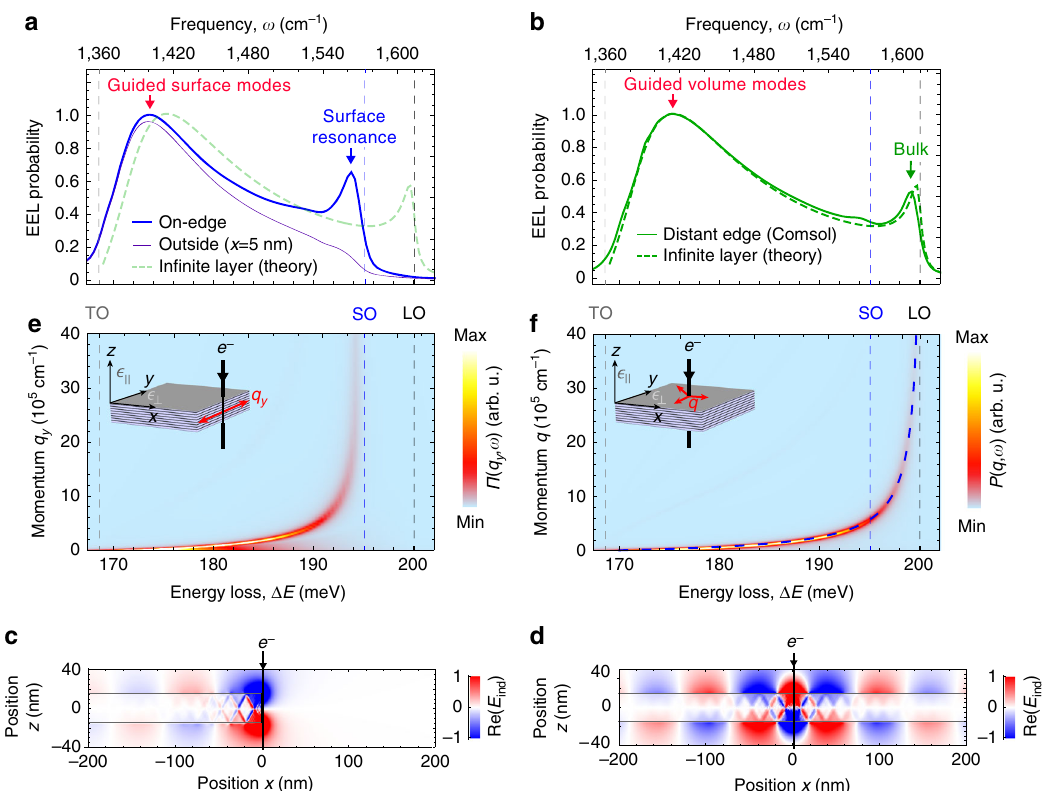
Fig. 5 Volume vs. edge-localized hyperbolic polaritons. a EEL probability spectrum of 30-nm-thick semi-in fi nite slab for an on-edge electron trajectory ( blue ) and for a trajectory 5 nm outside the slab ( thin purple ) obtained using full-wave simulation (Comsol). b EEL probability spectrum for the beam passing through the h-BN slab away from the edge (off-edge trajectory) obtained using Comsol ( solid green ). Dashed green spectra in a and b are retarded theoretical calculations (see Supplementary Note 5) using Eq. (1). c Cross section of the induced electric fi elds (z-component) taken at ω = 1570 cm − 1 for the on-edge electron trajectory. d Same as in c but for the off-edge electron trajectory. e Momentum dependent probability П ( q y , ω ) for the on-edge electron trajectory. f Retarded calculation of P ( q y , ω ) for a 30-nm-thick, laterally in fi nite h-BN layer (see Supplementary Note 5), i.e. the sum of contributions depicted in Fig. 2a – c, but with retardation included. Dashed blue curve marks the dispersion of M0-HPhP mode. Insets in e and f illustrate the electron trajectories and the polariton propagation directions. In all plots, the vertical dashed lines mark the TO, SO, and LO phonon